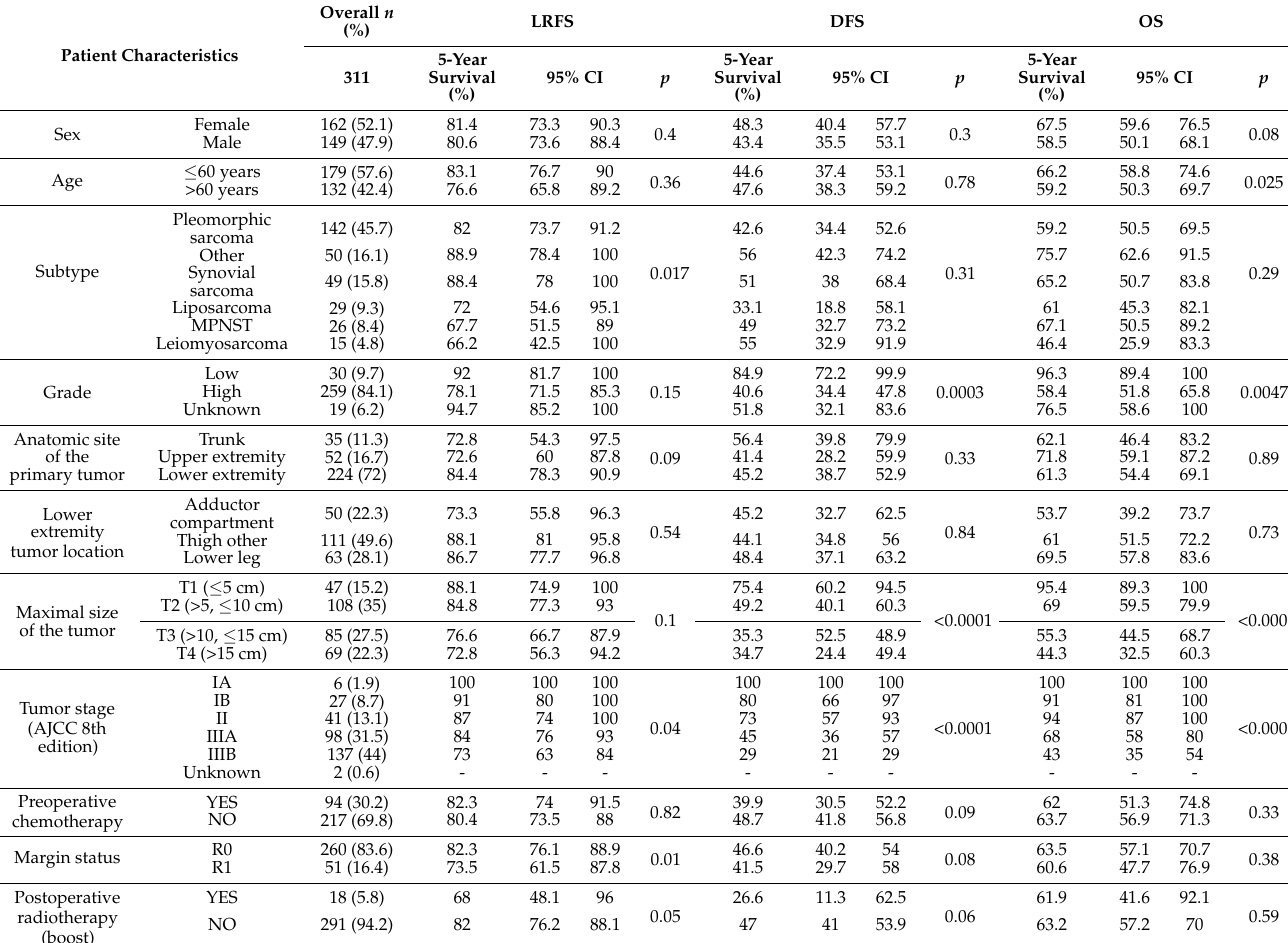
Table 1. Patient characteristics and univariate analysis of the following factors: LRFS, DFS, and OS.